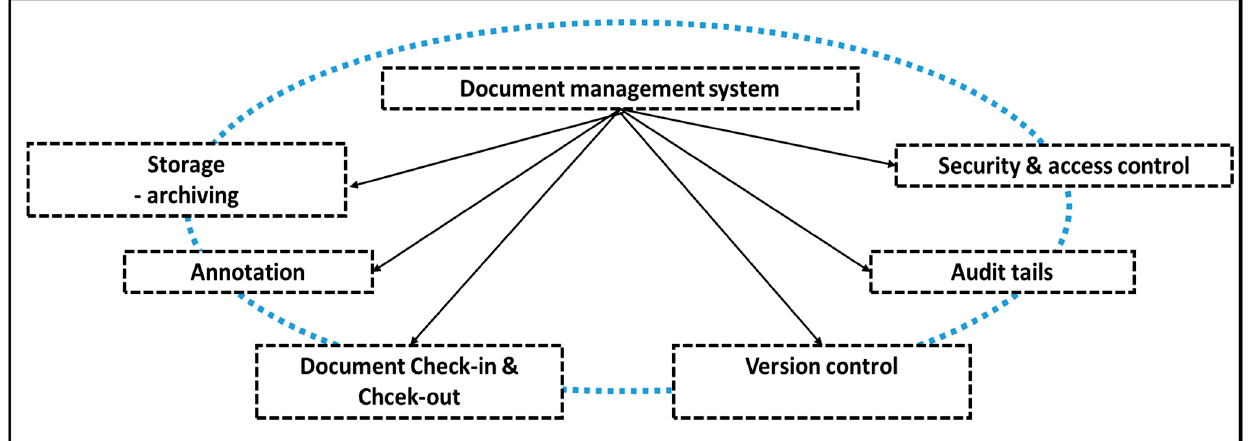
Figure 1. The document management system—general model.